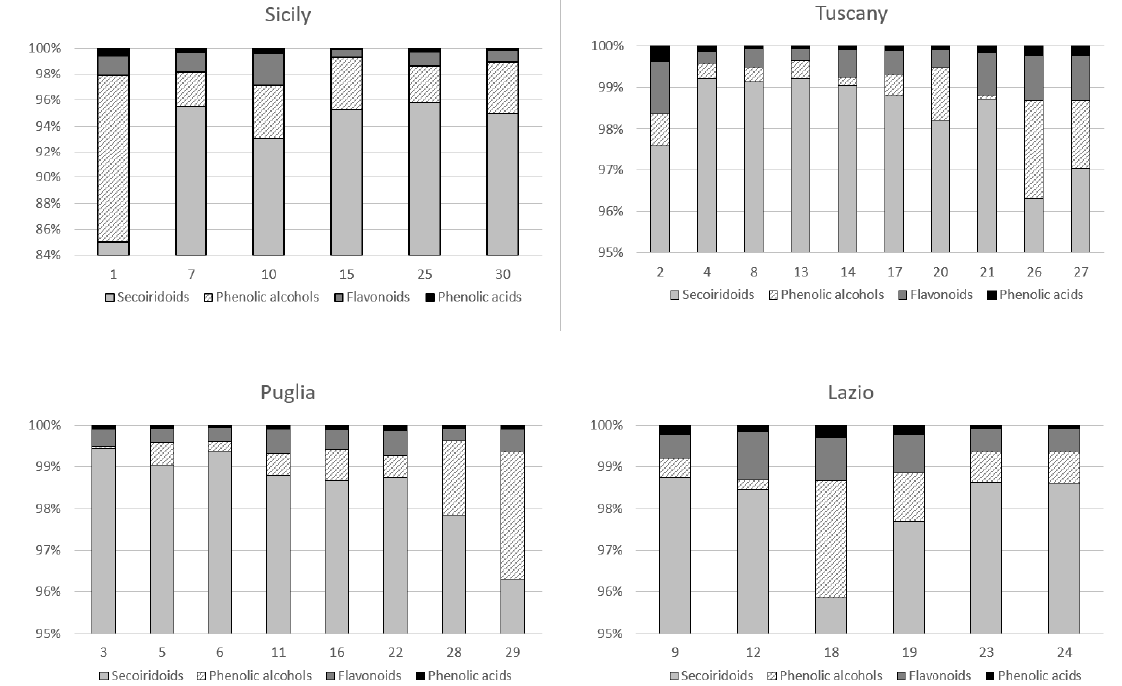
Figure 2. Percentage distribution of phenolic compounds classes (phenolic acids, phenolic alcohols, secoiridoids, and flavonoids) for each analyzed sample in the four different Italian areas (Sicily, Tuscany, Lazio, and Puglia). Sample number refers to Table S2.